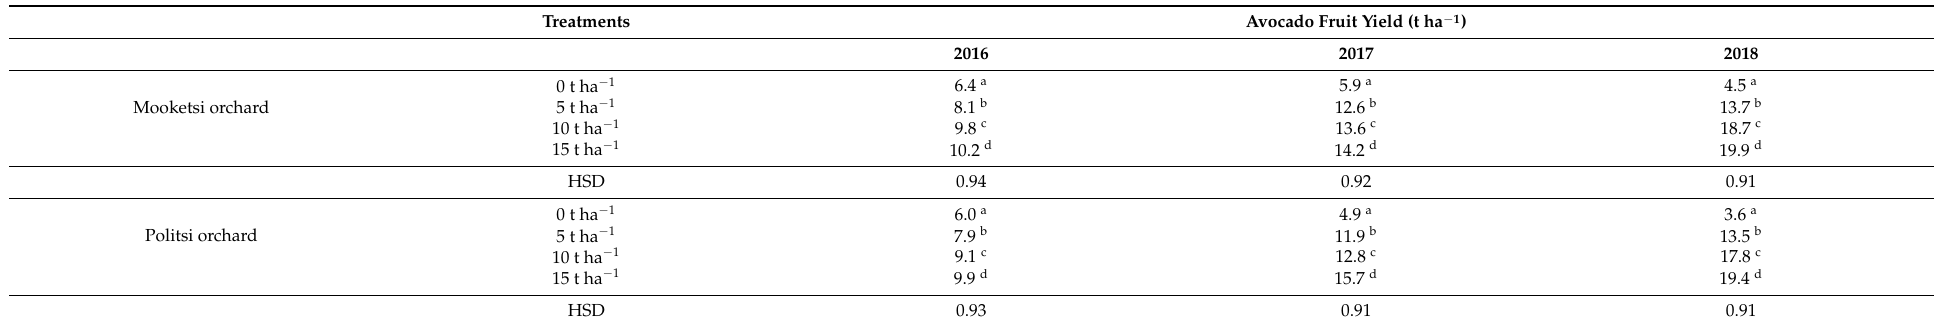
Table 5. Effects of the eucalyptus-wood-based compost application rates on avocado fruit yield during the three-year study (2016–2018) at Mooketsi and Politsi orchards.